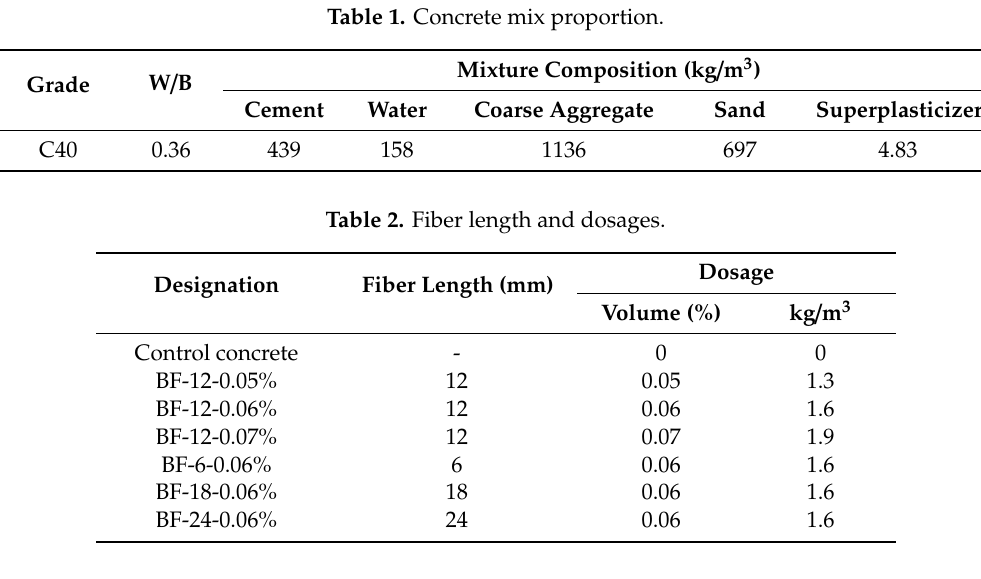
Table 3. Mass proportions of basalt fiber reinforced concrete (BFRC) mixes used.